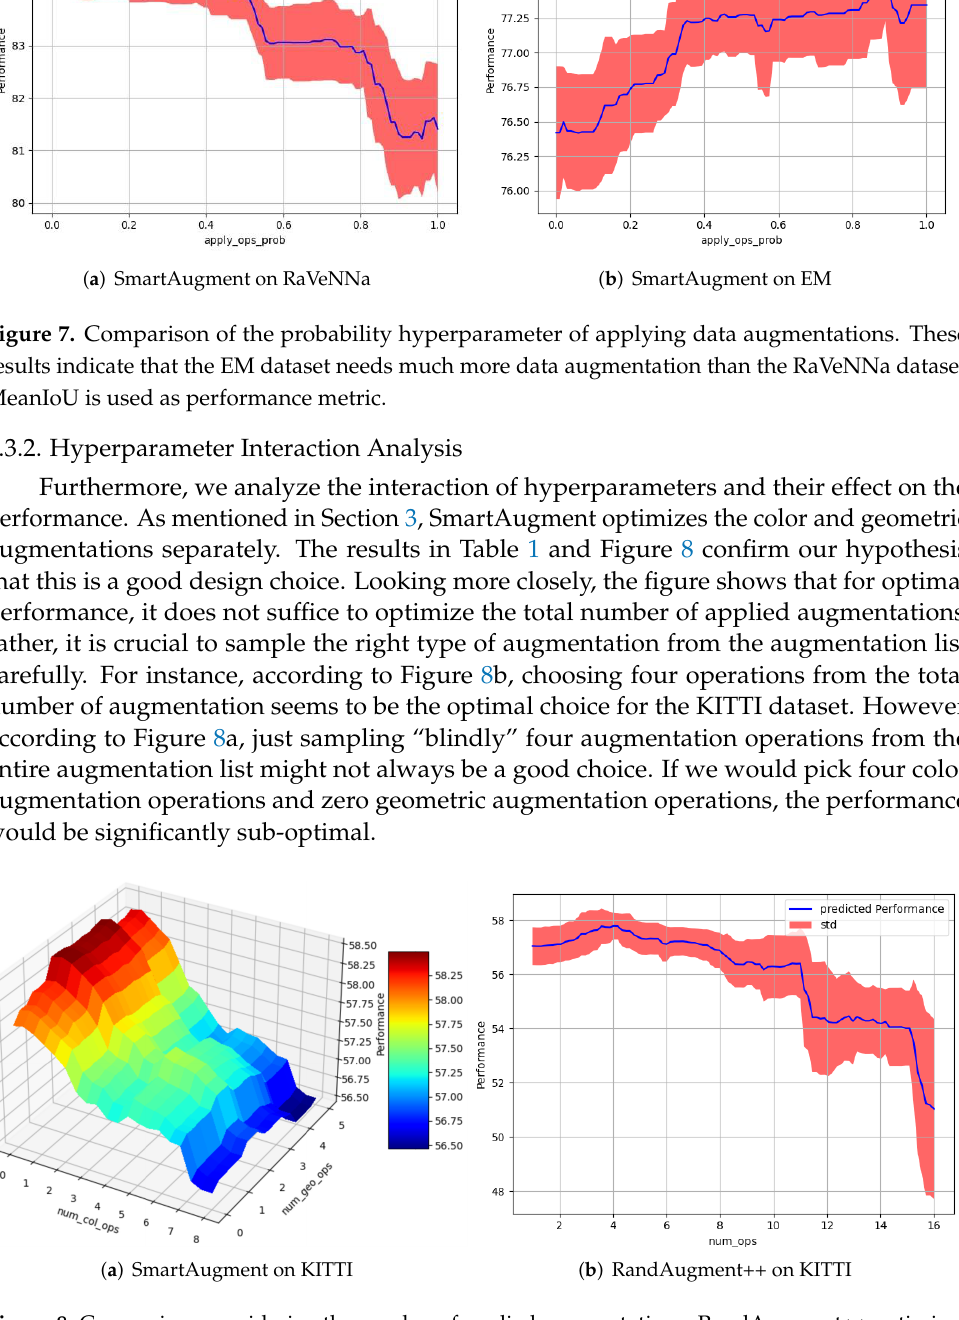
Figure 8. Comparison considering the number of applied augmentations: RandAugment++ optimizes the total number of augmentations, whereas SmartAugment differs between the number of color augmentations and geometric augmentations. This figure shows that the performance of a total number of augmentations depends on the types of augmentations. Please note that mean IoU is used as a performance